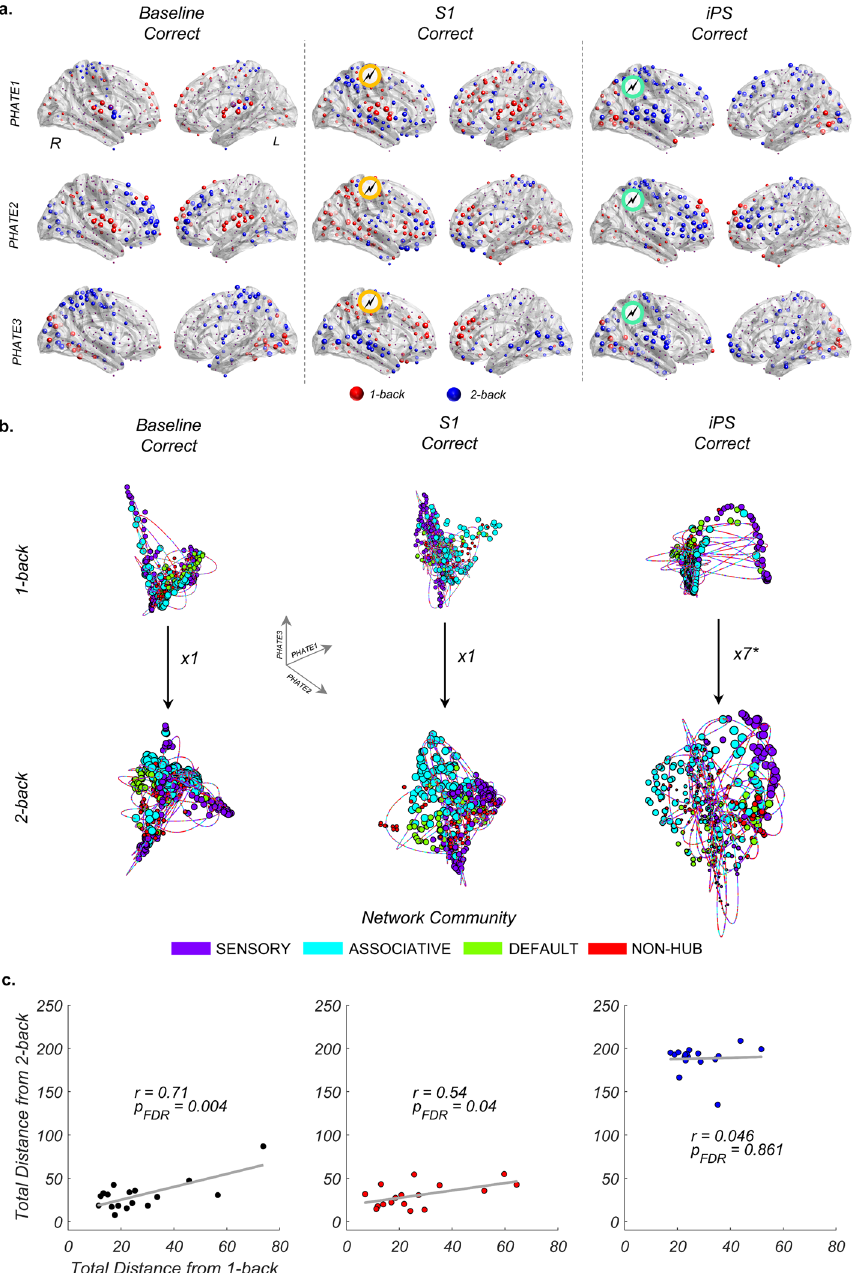
Fig. 1 Selective impact of local brain stimulation on the low-dimensional trajectories of brain activity across working memory loads and experimental sessions. a Spatial maps for the top three PHATE dimensions during n-back working memory tasks (1-back = red, 2-back = blue; the size of the spheres represents the relative weight of PHATE values; see “ Methods ” ). Network communities adopted from Gordon et al. 15 ( “ Methods ” ). The majority of nodes load onto task-positive brain regions constituting the visual, cingulo-opercular, dorsal attention, and frontoparietal networks. b The state-space embedding of trajectories of brain activity across working memory loads during ‘ correct ’ responses across baseline, S1 (task-irrelevant region targeted by TMS, indicated as yellow in a ), and iPS (task-relevant region targeted via TMS, indicated as green in a ). The size of the nodes represent the relative weight of PHATE values. The color of the trajectories indicates the engagement of brain regions belonging to speci fi c network communities. Here, asterisks indicate signi fi cant values (*p FDR < 0.001). c For each session, we calculated the difference between the within-session group trajectory and each participant ’ s trajectory (total summed Euclidean distance) during 1-back and 2-back trials. The relationship between these load-related trajectory distances revealed a load-induced scaling in the baseline and the S1 sessions, but not in the iPS session. Source data are provided as a Source data fi le. expansion was noticeable for correct 2-back trials (correct versus S1 sessions showed in Supplementary Fig. 4). Accordingly, incorrect: 3.4×, p FDR = 1.2 × 10 − 5 , Fig. 2a) and was most correct responses in the most challenging working memory prominent for 2-back correct trials in the iPS session (8.1×, condition following iPS stimulation relied on a larger expansion p FDR = 1.8 × 10 − 16 , Fig. 2b) compared to correct trials in the of the low-dimensional trajectory compared to responses in the baseline and the S1 sessions (expansions for baseline and baseline and the S1 sessions (Fig. 2c, d, F (2,48) = 229, NATURE COMMUNICATIONS| (2022) 13:4